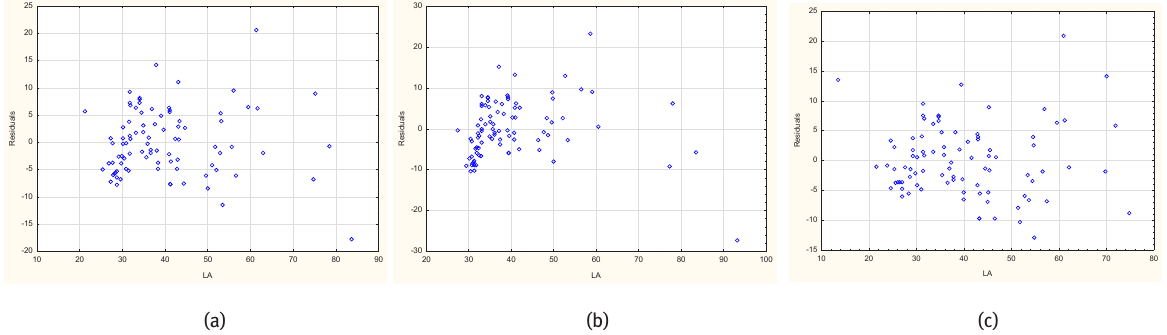
Figure 11: Regression analysis results: (a) linear, (b) exponential and (c) logarithmic. Fig. 10. Function fitting for all tested sandstones: (a) linear, (b) exponential and (c)